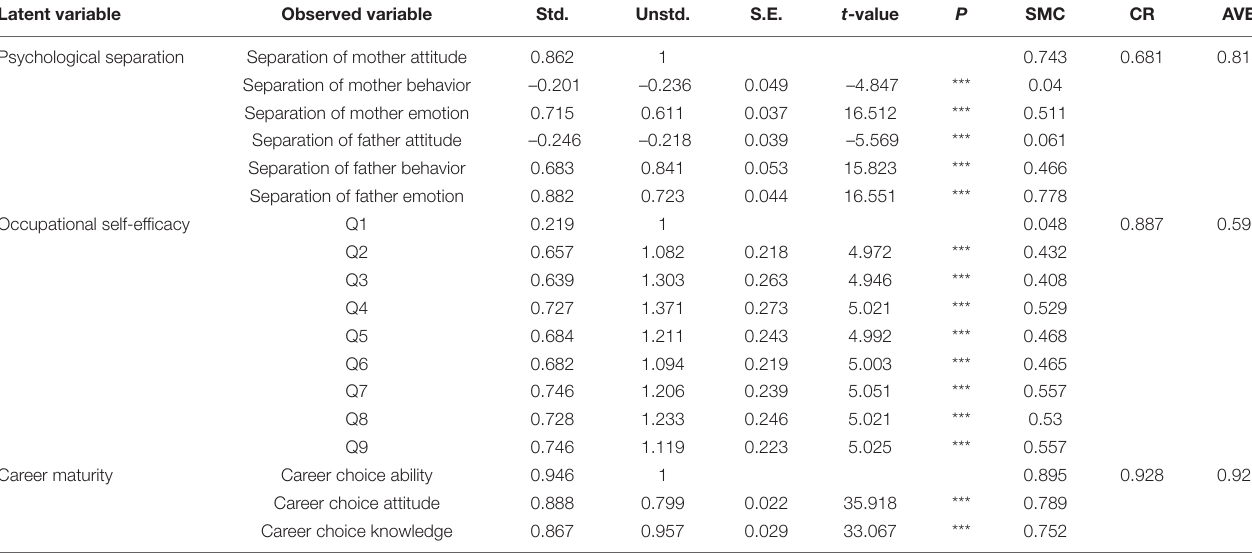
TABLE 2 | Convergence validity test of model variables.